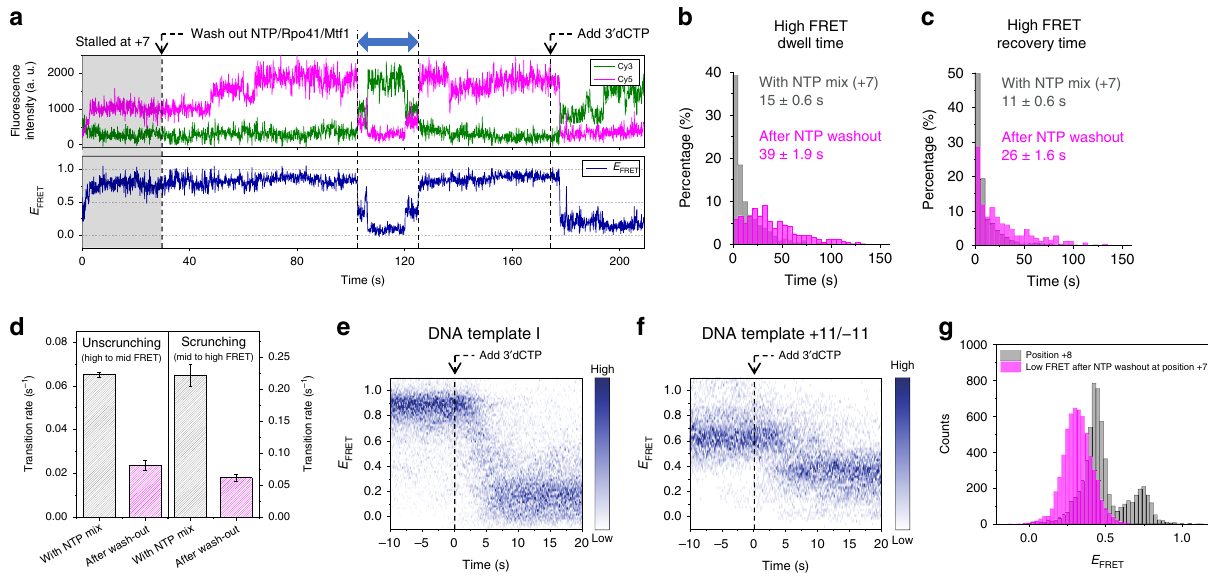
Fig. 6 The stalled initiation complex makes conformational transitions without dissociating RNA. a Representative smFRET trace showing the conformational dynamics of the TIC of DNA template II equilibrated at position + 7 (gray region; 0.5 mM each of ATP, GTP, and UTP) after washing out the NTP mix ( fi rst arrow). Subsequently, 0.5 mM 3 ′ dCTP was added to promote progression to position + 8 (second arrow). The abrupt drop in the FRET ef fi ciency indicates successful progression to position + 8. b Dwell time histogram of the high FRET (scrunched) state in the presence of NTP mix (gray; 809 events) and after NTP washout (magenta; 214 events). c The time taken to recover the high FRET state after dropping to lower FRET levels (blue arrow in a ) in the presence of NTP mix (gray; 843 events) and after NTP washout (magenta; 284 events). d Comparison of unscrunching and scrunching rates in the presence of NTP mix and after NTP washout, measured as the inverse of average dwell times in b and c . Data represent mean and s.e.m. from three independent measurements. e , f FRET evolution maps generated from the traces supplied with 0.5 mM 3 ′ dCTP after long stalling at position + 7 by washing out the NTP mix, synchronized at the moment of fl owing in 3 ′ dCTP (0 s). The 53 and 41 traces were used for the maps generated for DNA templates II and + 11/ − I D + β I D 11, respectively. g Using DNA template + 11/ − 11, FRET histogram of low-FRET events after NTP washout at position + 7 (magenta) was compared to that of position + 8 (gray, from Fig.